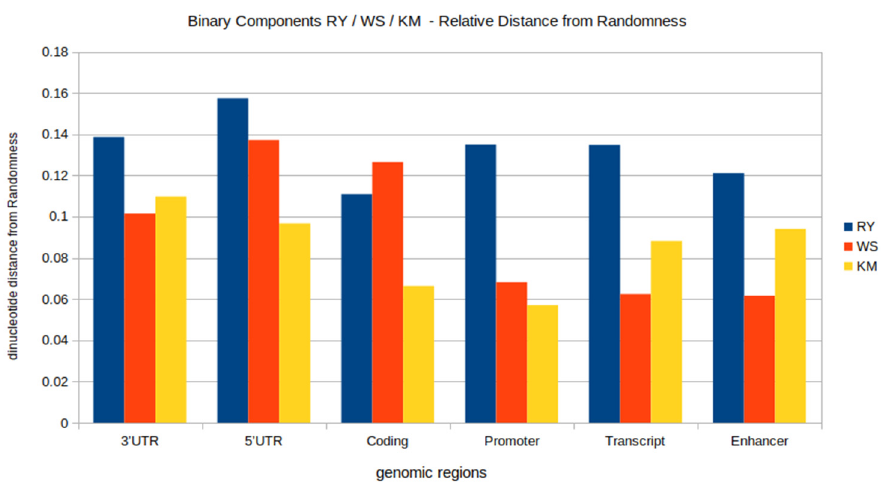
Figure 3. Distance from randomness for the different genomic regions, using binary components analysis (RY/WS/KM) of sequences. The profile shows the average (mean) distance from randomness of the different genomic regions, including; the 5 (cid:48) UTR, 3 (cid:48) UTR, protein-coding, promoter, transcript, and enhancer sequences. The relative dinucleotide distance from randomness for each of the RY, WS, and KM sequences for the genomic regions is shown. These are distinct sequence regions, each with their own type of functionality, and each one displays a distinct profile which distinguishes it from the other genomic sequence locations. The RY binary component is least random of most of the genomic regions, including 3 (cid:48) UTR, 5 (cid:48) UTR, the promoter, transcript and enhancer. All of these are non-protein coding sequences, with the exception of transcript. Whilst the transcript contains protein-coding sequences, it is mostly non-coding. The WS binary component is least random only of the coding DNA. In most other locations, this is the most random component. The KM binary component varies depending on sequence type; however, it is never the least random feature in any of the genomic regions analysed. A marked distinction, though, is seen between promoters and enhancers. In the promoter, it is the most random component, whereas in the enhancer it is not. This marks a potential distinguishing feature between these two types of non- coding DNA. This analysis permits a within-region comparison of relative RY, WS, and KM non- randomness.